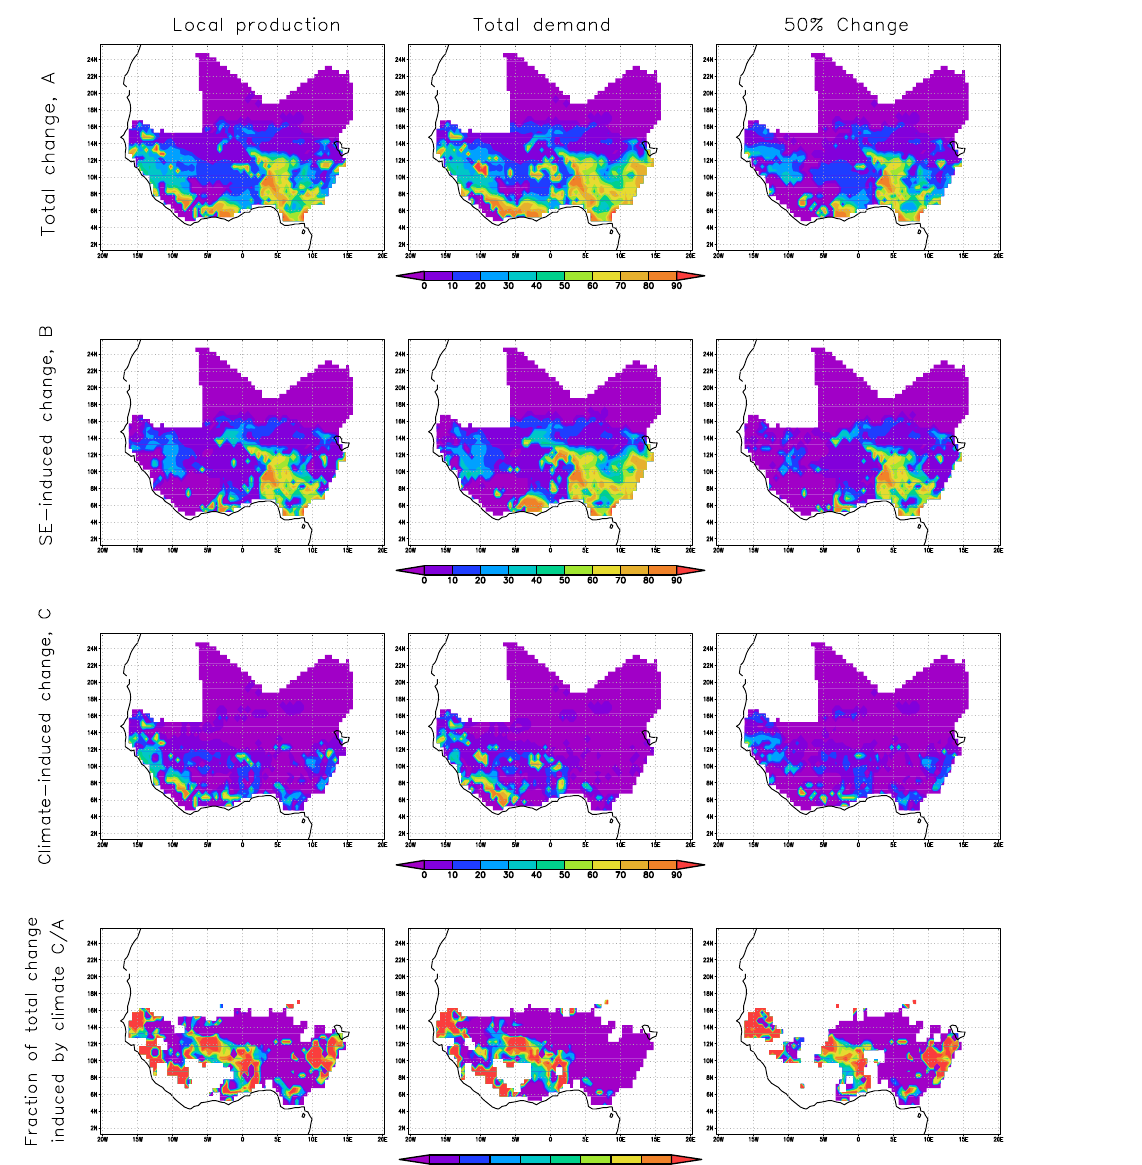
Figure 4. Similar to Fig. 3, but for CESM-driven climate. (Note that the SE-induced changes in Figs. 3 and 4 are the